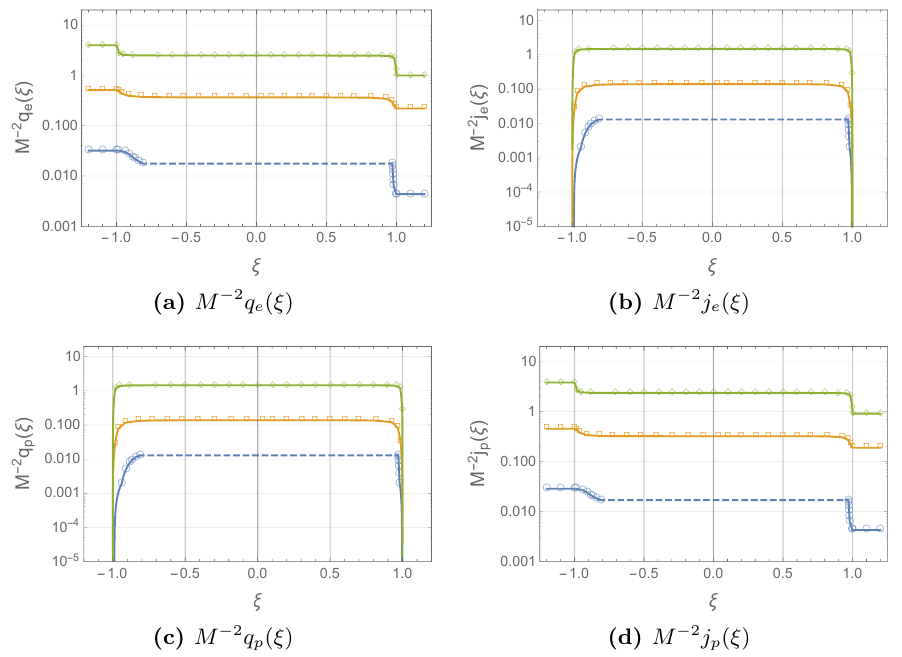
Figure 7. Ray-dependent (a) energy density q e , (b) energy current j e , (c) momentum density q p and (d) momentum current j p in the W 3 ! W 3 massless (cid:13)ow after bipartite quenches at the Euler 5 4 scale. The green curve with diamonds corresponds to left and right initial temperatures T l = 2 : 5 M and T r = 1 : 25 M , the orange curve with squares to T l = 0 : 9 M and T r = 0 : 6 M and the blue curve with circles to T l = 0 : 25 M and T r = 0 : 1 M . The discrete points in the plots indicated by the plotmarkers are obtained by the numerical solution of GHD equations, the continuous curves are (cid:12)rst order interpolations. The dashed part of the curves indicates the region of constant densities and currents. Due to relativistic invariance, j e = q p